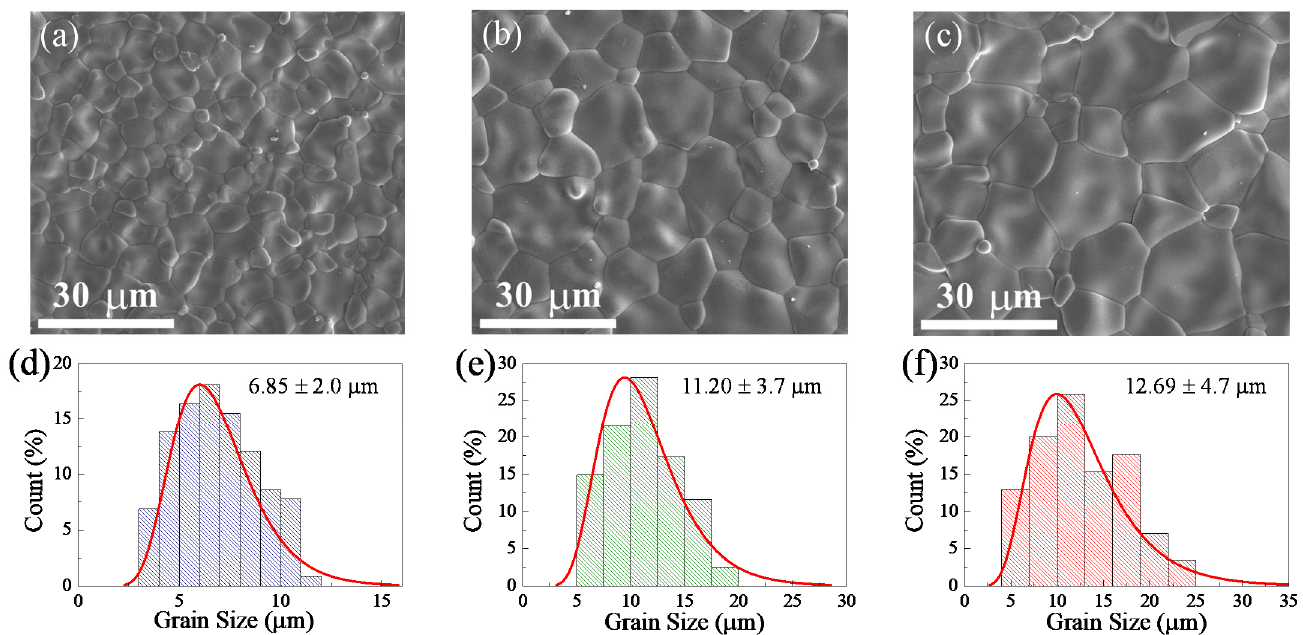
Figure 2. SEM images of the ( a ) 2.5%WTO-1400, ( b ) 0.25%WTO-1500, and ( c ) 2.5%WTO-1500 ceramics. Grain size distribution of the ( d ) 2.5%WTO-1400, ( e ) 0.25%WTO-1500, and ( f ) 2.5%WTO-1500 ceramics.